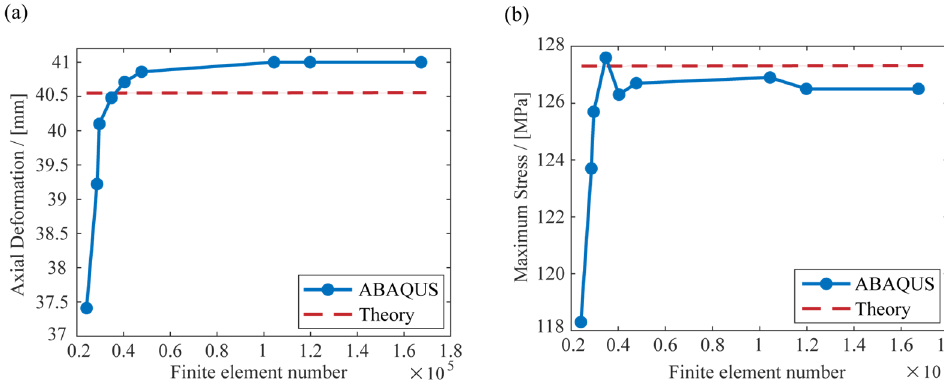
Figure 16. Comparisons of ( a ) axial deformation and ( b ) maximum stress between results of ABAQUS and theory by changing the number of finite elements. Red dashed line represents the theoretical result; the blue line connecting blue points represents the ABAQUS result.